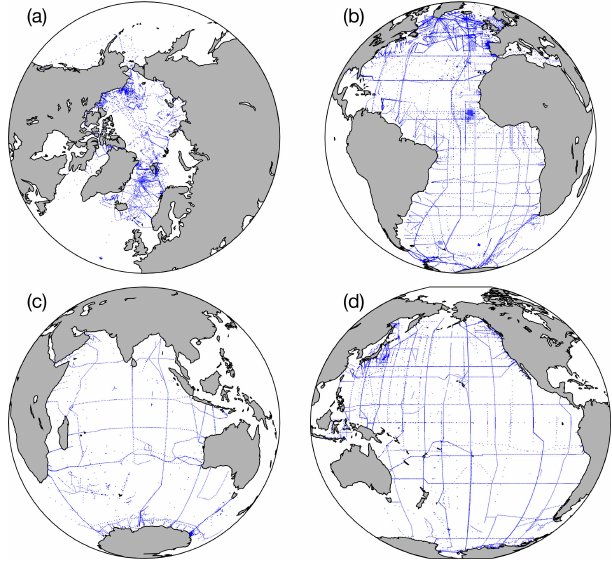
Figure 9. Locations of stations included in the (a) Arctic, (b) At- lantic, (c) Indian, and (d) Pacific ocean product files for the whole GLODAPv2.2019 data